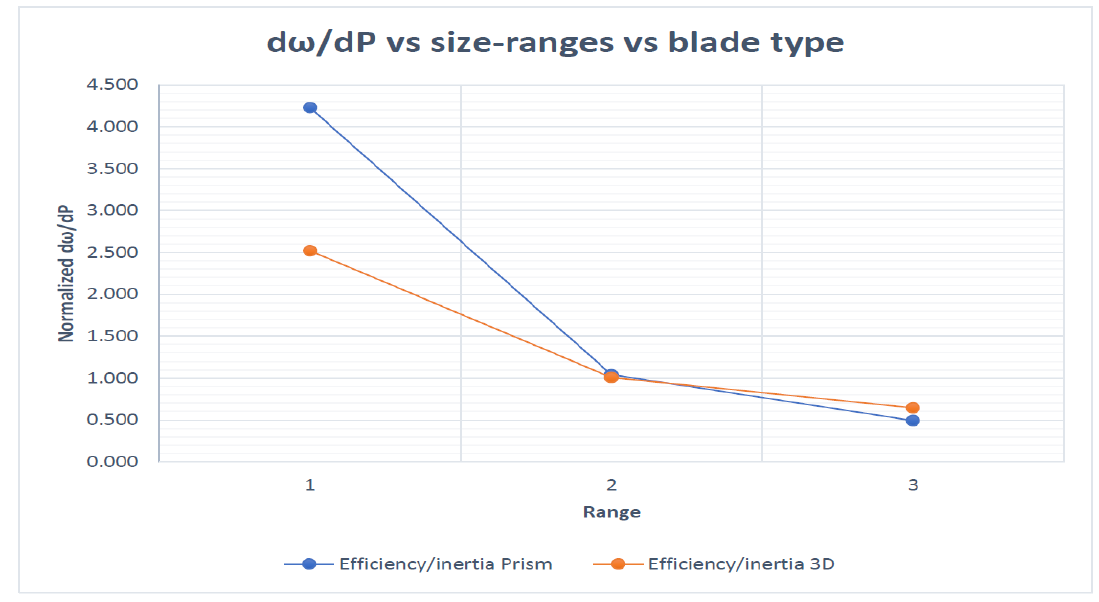
Figure 24. Spool-up factor (d ω /d P) vs. size ranges vs. blade type.